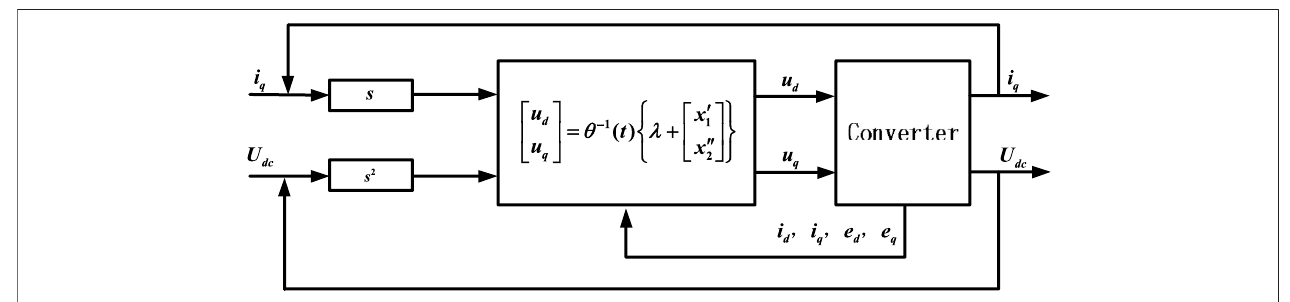
FIGURE 3 | Non-linear control strategy of grid-connected